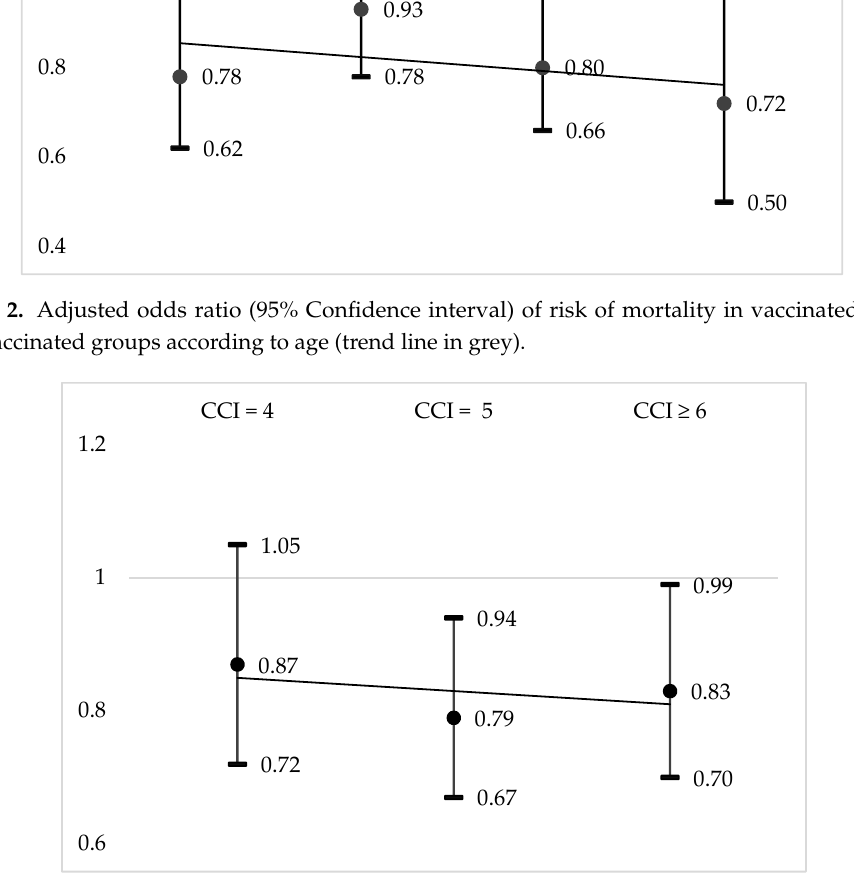
Figure 3. Adjusted odds ratio (95% Confidence interval) of risk of mortality in vaccinated versus non-vaccinated groups according to Charlson Comorbidity Index (CCI) (trend line in grey).